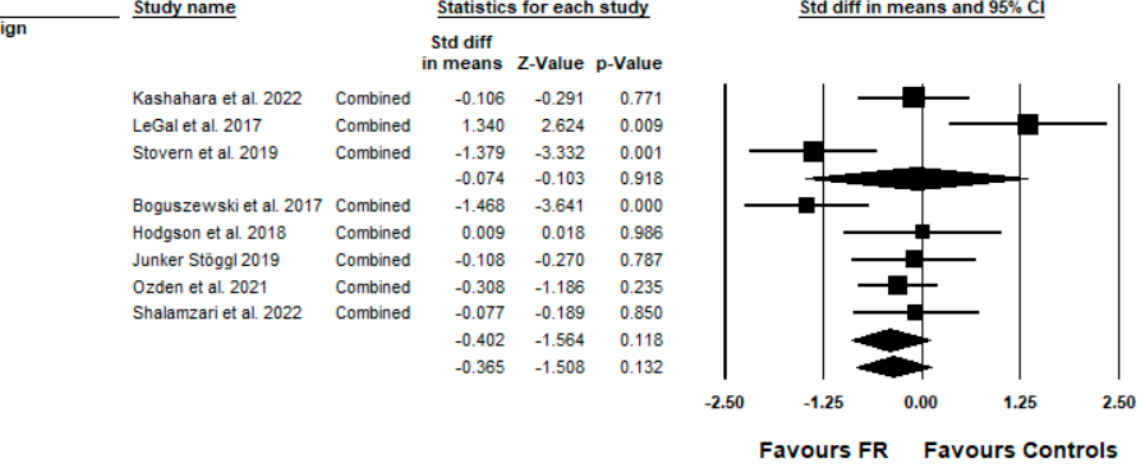
Figure 4. Forest plot presenting the subgroup analysis of study design (controlled trials (CT) vs. randomized controlled trials (RCT)) from the eight included studies (squares) that investigated the effects of foam rolling (FR) on performance parameters (ROM) [26–33]. Std diff in means = standardized difference in means; CI = confidence interval; combined = mean of the selected outcomes of one study. Diamond represents mean standard difference in means of the studies.